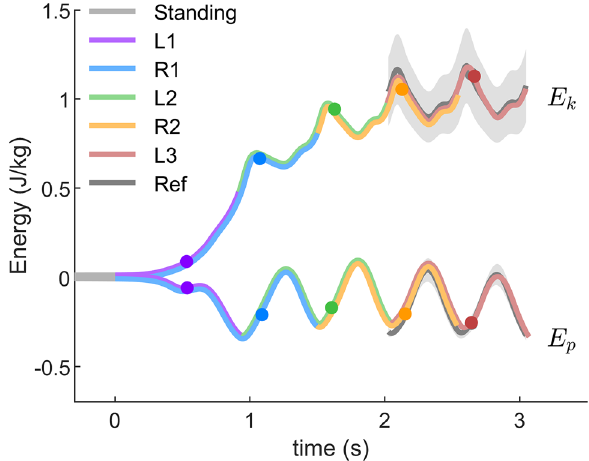
Figure 6. The CoM kinetic ( E k ) and potential ( E p ) energy during normal velocity gait initiation. Solid lines denote the mean value over 23 subjects. Time 0 is defined as the starting of the gait initiation. E p during standing is defined as zero. Ref denotes overground walking at self-selected preferred velocity. The error bands denote ± 1 standard deviation. Different colors denote different strides. L1, L2, L3 denote the first, second, and third stride on the left side, respectively. R1 and R2 denote the first and second stride on the right side, respectively. The dots denote the take-off timing.